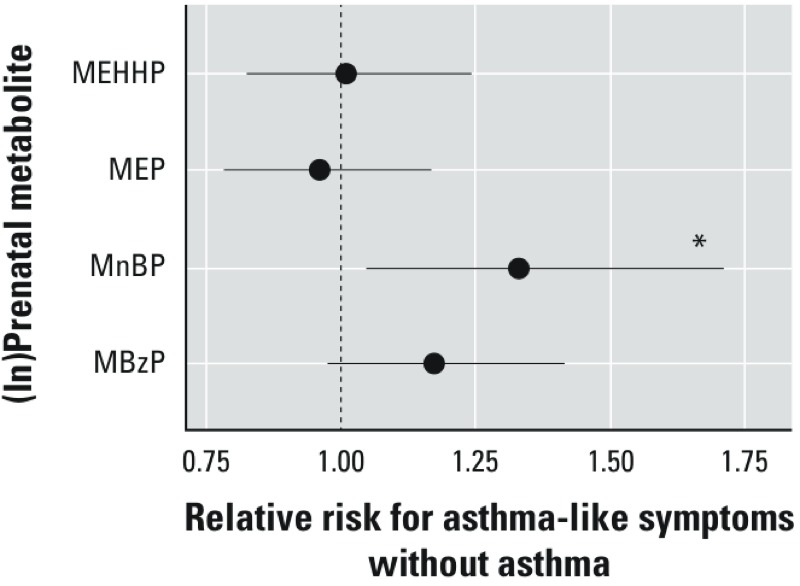
Association between maternal prenatal (ln)phthalate metabolites concentrations and diagnosis as not current asthma among children with a history of the asthma-like symptoms (n = 60) compared with children without any history of asthma-like symptoms classified as nonasthmatics (n = 146). RRs were estimated using Poisson regression with robust standard error estimation using the generalized estimating equations controlling for maternal asthma, household tobacco smoke exposure, maternal prenatal BPA, maternal prenatal demoralization, child age, and maternal prenatal specific gravity.
*p < 0.05.